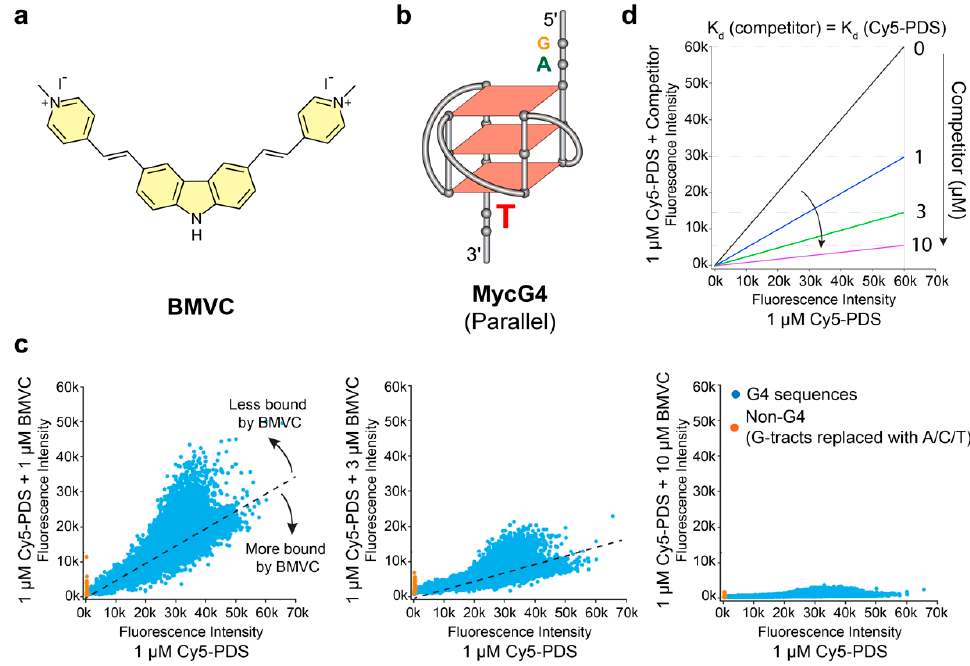
Figure 1. The binding of 3,6-bis(1-Methyl-4-vinylpyridinium) carbazole diiodide (BMVC) to various G4 structures differs from pyridostatin (PDS). ( a ) Chemical structure of BMVC. ( b ) MycG4, the major G-quadruplex formed in the MYC promoter NHE III 1 in K + solution, a parallel-stranded G4 structure. ( c ) Competition experiments of DNA microarrays with thousands of G4 sequences showing the differential binding of BMVC to various G4s as compared to Cy5-fluorophore ( λ ex,max = 647, λ em,max = 665) labeled small molecule pyridostatin (Cy5-PDS), as shown by Cy5-PDS fluorescence intensity. The competition experiments were performed in the presence of 1, 3, and 10 µM BMVC. The black dashed lines represent predicted linear relationships when the binding affinities of BMVC and PDS are the same. G4-containing sequences are shown in blue spots. Non-G4 forming sequences are shown in orange spots and serve as negative controls. Each spot represents the average of two independent measurements (Figure S1). ( d ) Schematic diagram showing the predicted linear relationships when the competitor has the same binding a ffi nities as Cy5-PDS. The competition e ff ects can be revealed by a dose-dependent slope